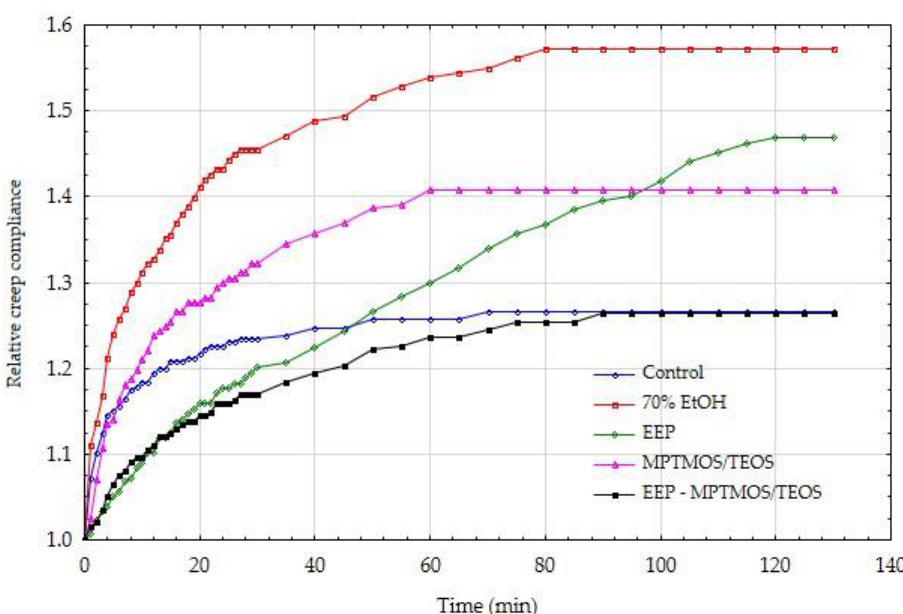
Figure 5. Relative creep compliance of dry wood, protected by various means.